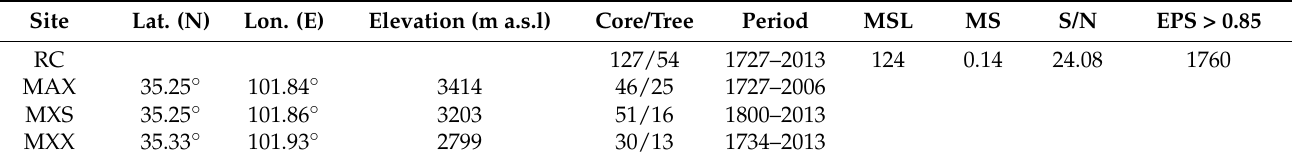
Table 1. Statistical characteristics of the regional